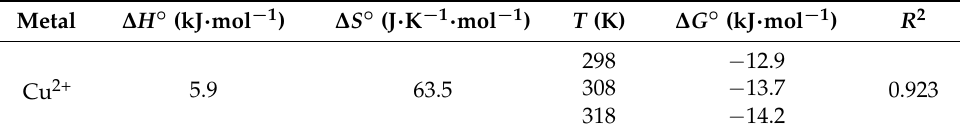
Figure 5. Temperature effect on copper adsorption ( a ) and plot of ln K d versus 1/ T ( b ) (at pH 6 and m = 20 mg). Table 3. Thermodynamic parameters for Cu 2+ adsorption on CMK ‐ 3.